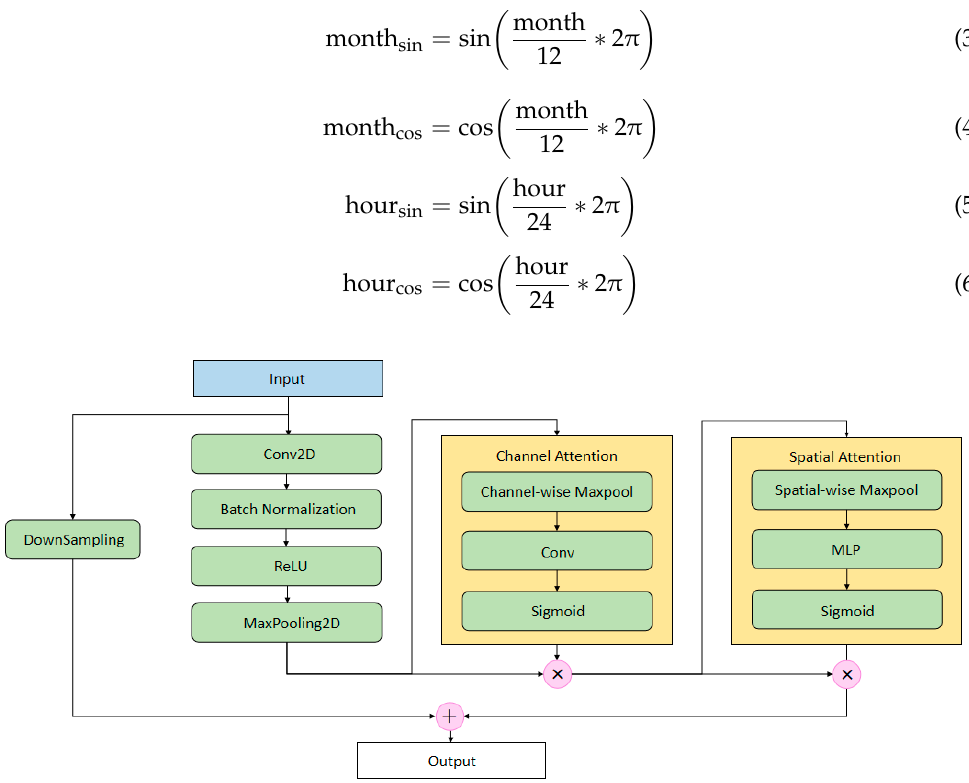
Figure 6. Structure diagram of the Wave and Wind field Feature Extraction (WWFE)